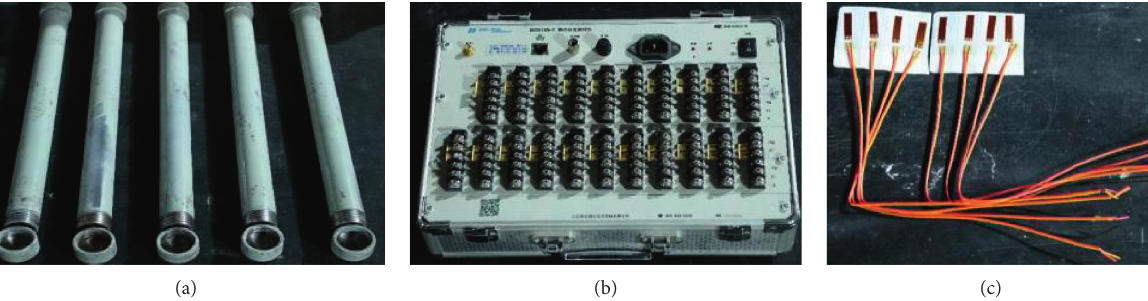
Figure 5: Instruments and equipment required for swelling force testing experiment: (a) 304 stainless steel pipe, (b) swelling force tester, and (c) resistance strain piece.